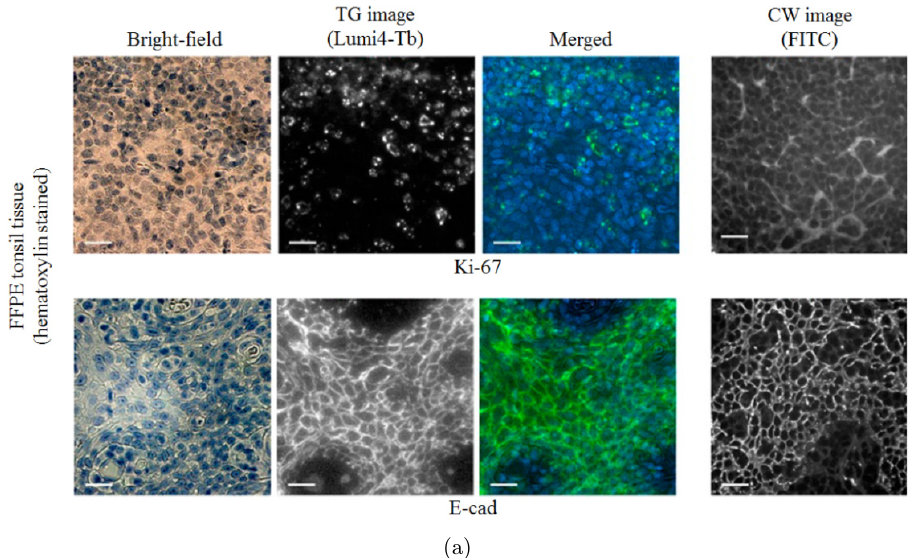
Fig. 13. (a) FFPE tonsil tissue was stained with hematoxylin, labeled with primary antibodies against Ki-67 (top) or E-cad (bottom), and stained with Lumi4-Tb (TG image) or FITC (CW image) using tyramide signal ampli¯cation. Merged images consists of bright-¯eld images (log-transformed into a pseudo-dark¯eld presentation) and TG images. (b) Tonsil tissue was stained with H&E prior to antigen retrieval, primary antibody labeling (Bcl-6 or MSH-6), and TSA-mediated deposition of Lumi4-Tb or FITC. In these images, robust, speci¯c Lumi4-Tb signals were observed in TG images while FITC signals could not be detected. Scale bars: 20 (cid:3) m. Reprinted with permission from Ref.